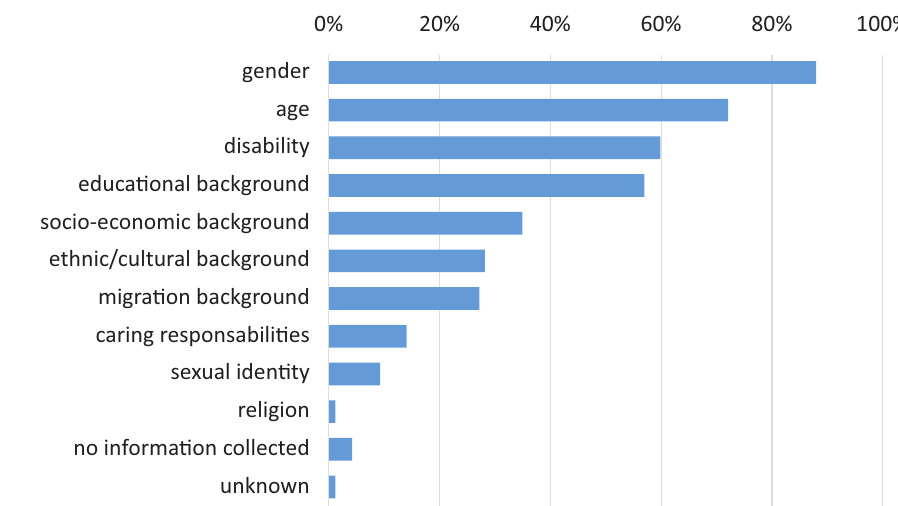
Figure 2. Percentage of responding HEIs by type of underrepresented group for which information is collected (N = 159). Social Inclusion, 2021, Volume 9, Issue 3, Pages